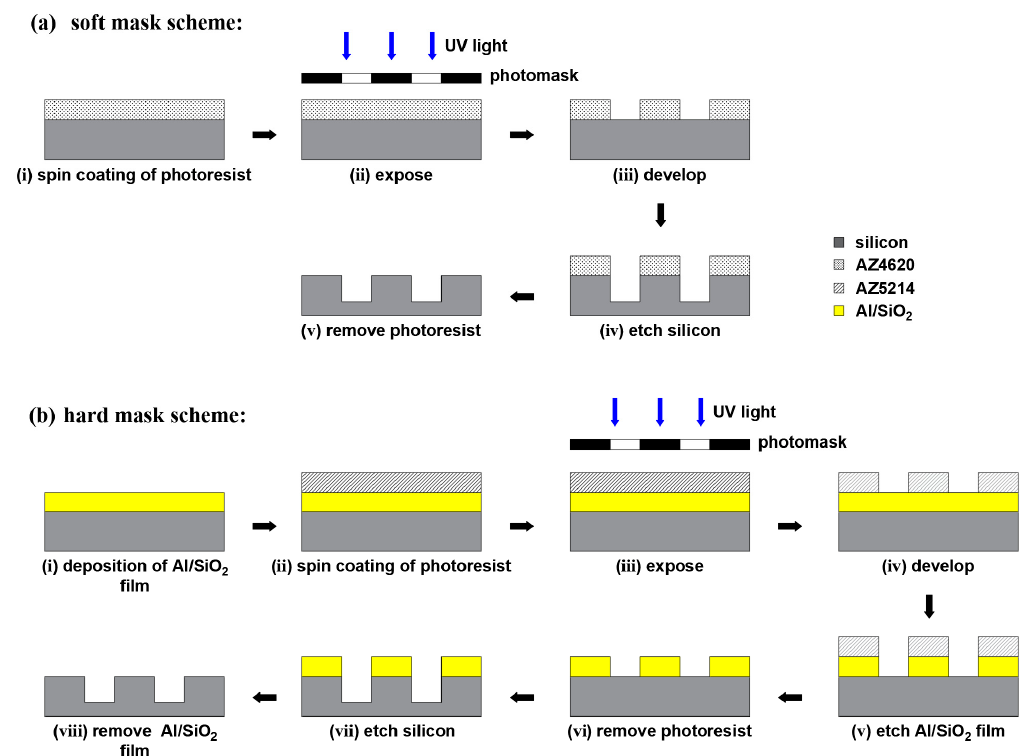
Figure 2. Schematic illustration of ICP etching MOG spiral trenches: ( a ) soft mask scheme and ( b ) hard mask scheme.